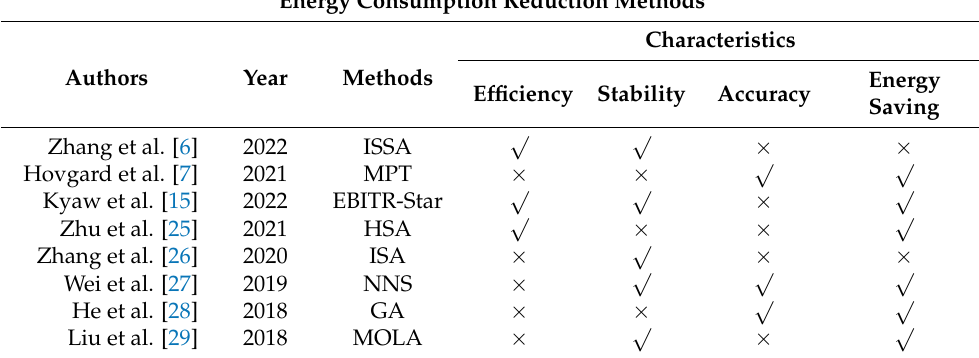
Table 1. Energy consumption reduction